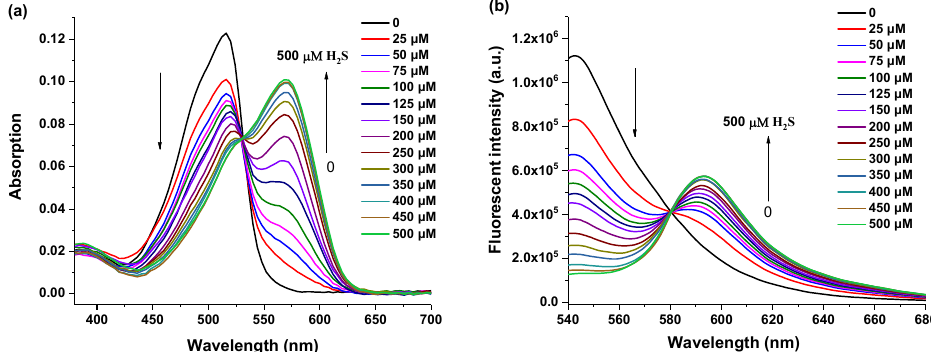
Figure 1. The absorption ( a ) and fluorescence ( b ) spectrum changes of probe BH (5 µ M) toward different concentration of H 2 S (0–500 µ M) in aqueous solution of DMSO/PBS ( v / v 1/1, pH 7.4), recorded after 60 min.